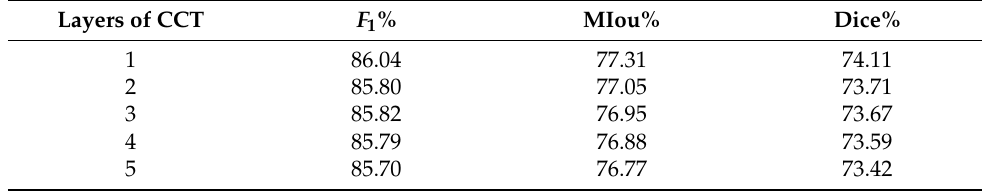
Table 4. Performance with different numbers of layers.